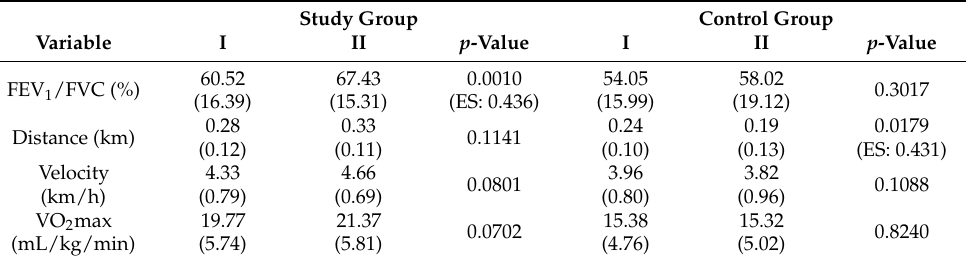
Table 2. The effect of 30 min daily endurance training on spirometric parameters (FEV 1 /FVC), VO 2 max, and distance covered (mean (SD)) on the treadmill